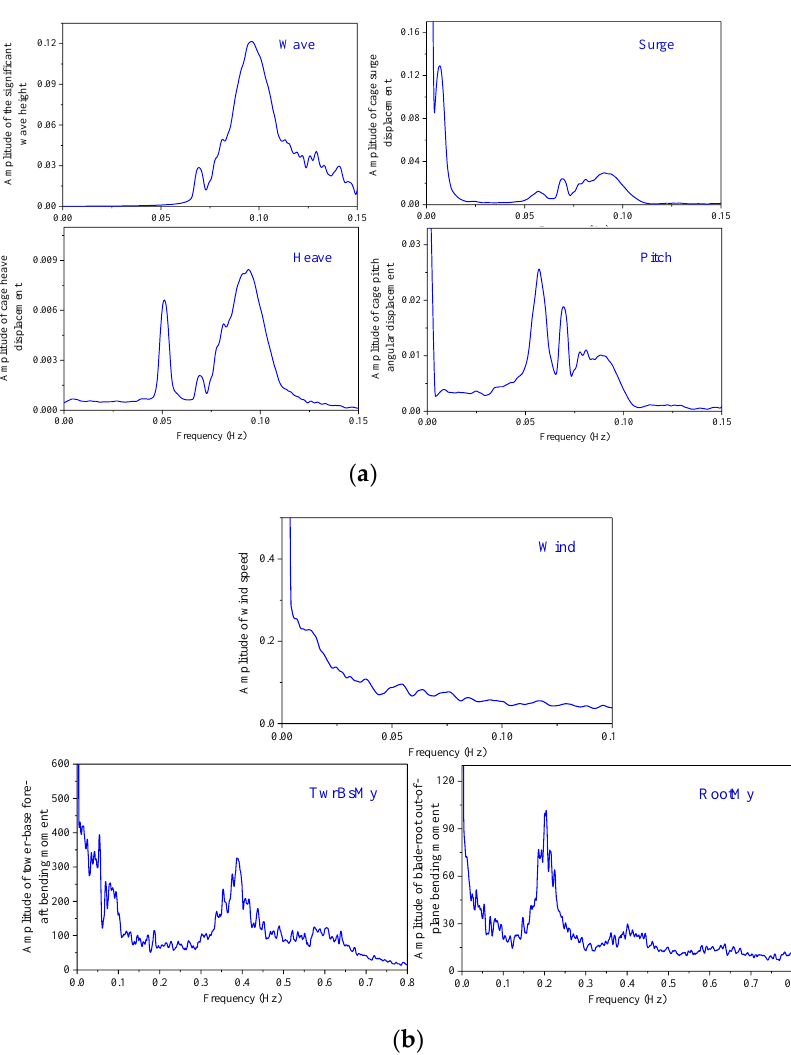
Figure 18. Smoothed spectra of the cage and wind turbine responses under condition 3. ( a ) Cage responses. ( b ) Wind turbine responses.